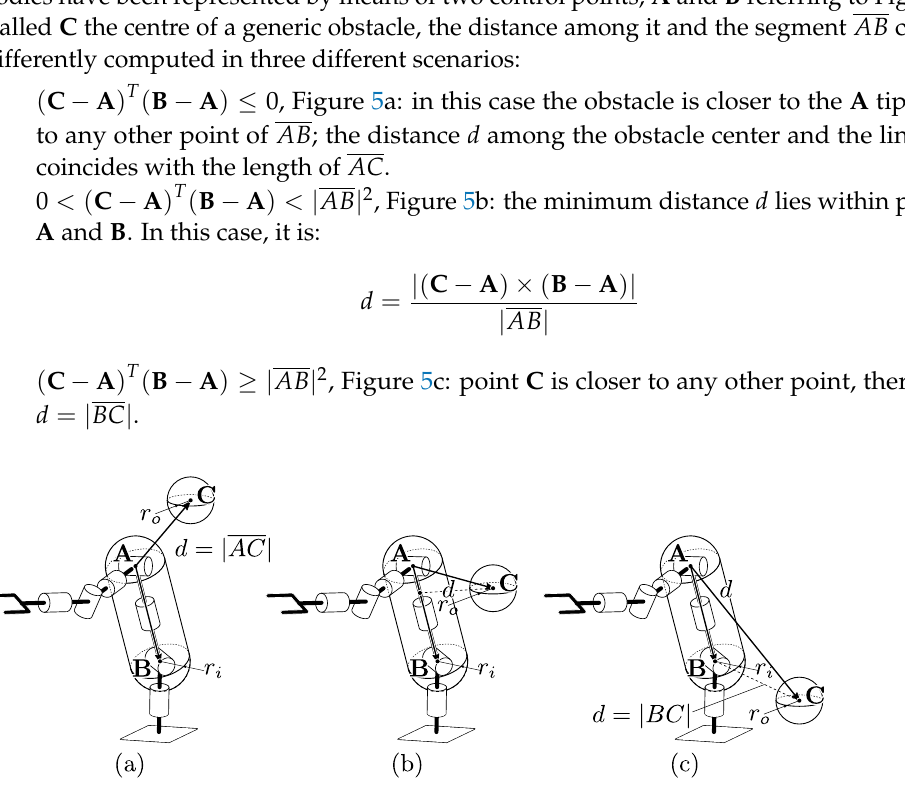
Figure 5. ( a – c ): obstacle to robot body distance in the three considered